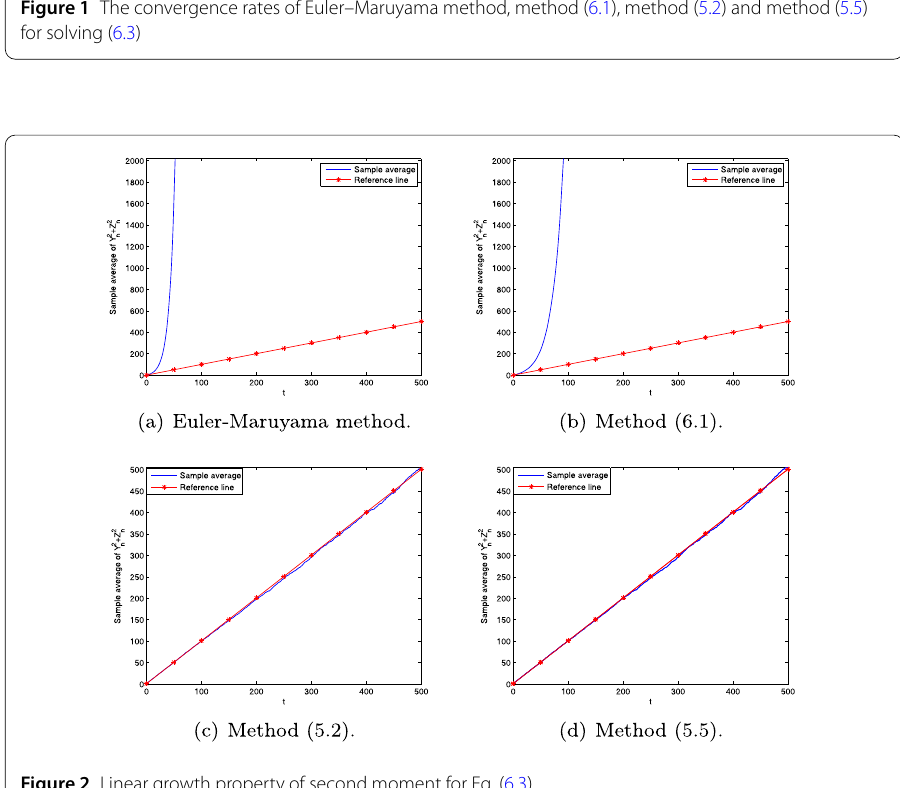
which means S n = S 0 , where S n denotes the area of the triangle at time t n , namely, value S n / S 0 should remain at 1 along the exact flow of (6.3). Let σ = 1 and points for the initial triangle be (0,0),(1,0),(1,1), the Euler–Maruyama method, method (6.1), method (5.2), method (5.5) are applied to solve (6.3) with h = 0.1 and T = 100. The evolution of the quantity S n / S 0 along the numerical solutions is illustrated in Fig. 3. The changes of the triangles along the numerical solutions are displayed in Fig. 4. From Fig. 3 and Fig. 4, it is easy to see that method (5.2) and method (5.5) can preserve the symplecticity of (6.3) exactly, while the Euler–Maruyama method and method (6.1)